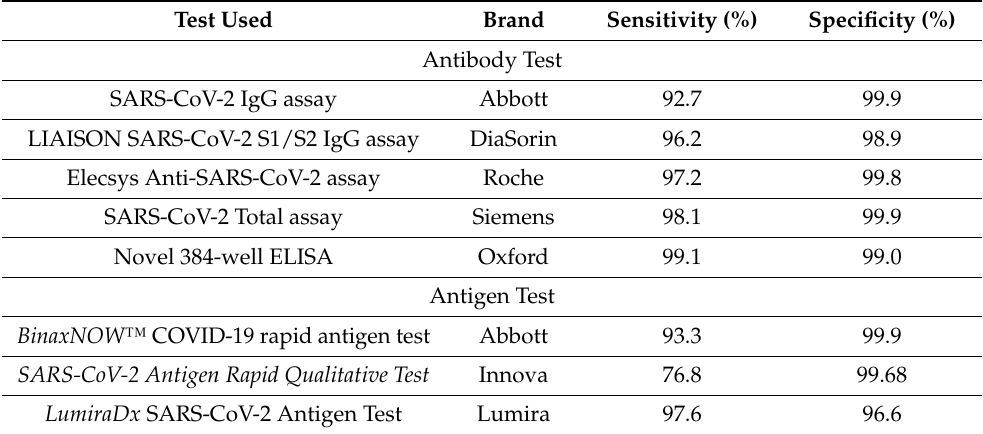
Table 2. Different commercial antibody and antigen test kits used to detect COVID-19 followed by their reported sensitivity and